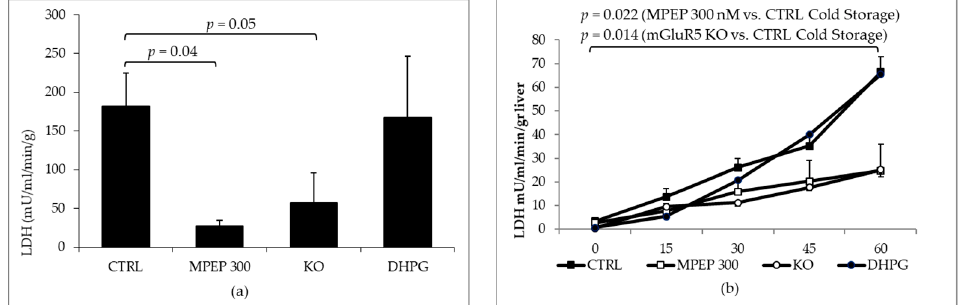
Figure 6. MPEP 300 nM reduced LDH release during cold storage and LDH release rate during warm